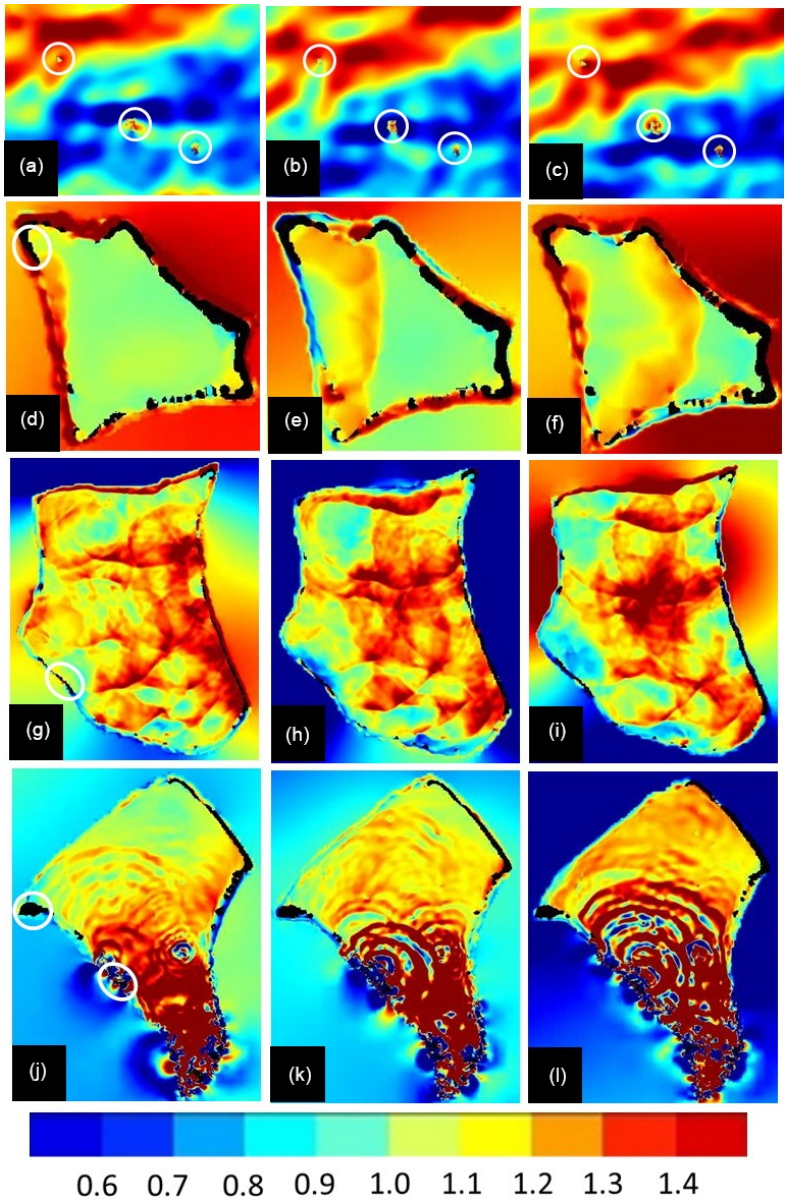
Figure 10. Illustrative snapshots of wave fields within atolls generated from the Kuril-source MHWS simulation. Columns show water heights (relative to initial value at MHWS) for successive 100s increments progressing from left to right in all three columns, the left-hand column at 1h after the first wave-train arrival at Atafu. The top row (a–c) shows the oceanic wave field, the location of the three atolls within the white circles (Atafu, Nukunonu, and Fakaofo from left to right). The second row of frames (d–f) focuses on Atafu and follows the same time sequence as the top row, and similarly for Nukunonu (g–i) , and Fakaofo (j–l) . The colour scale bar along the base of the columns indicates the range of water heights from 0.5 to